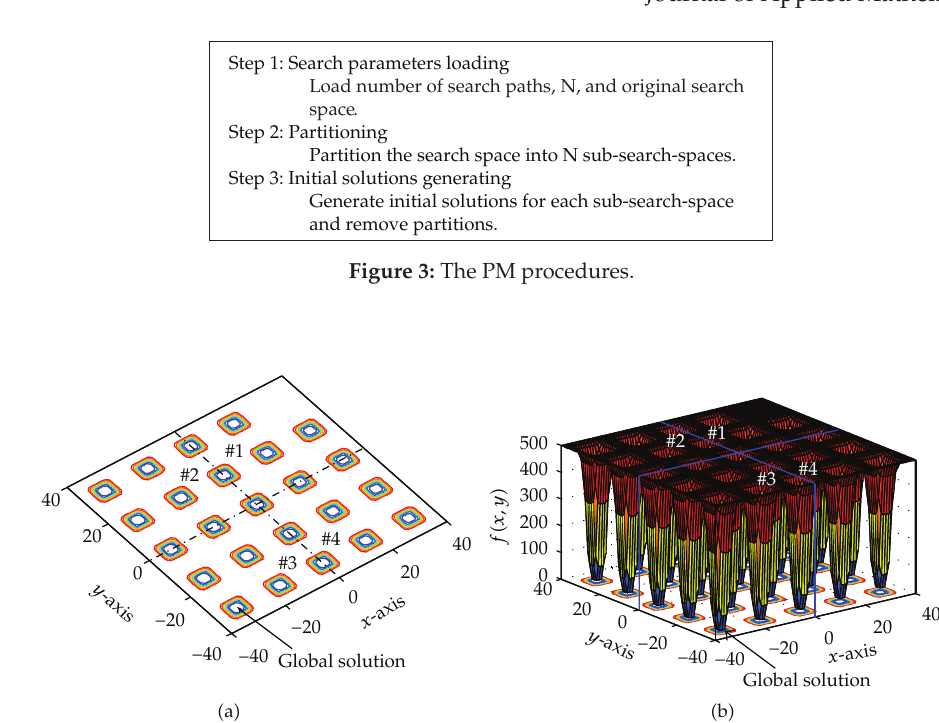
Figure 4: Partitioned surface of the SF: (cid:4) a (cid:5) 2D contour, (cid:4) b (cid:5) 3D